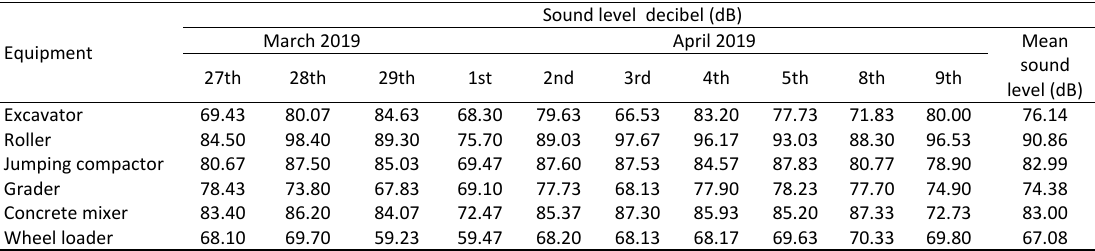
Table 3: The mean sound levels from the construction equipment studied